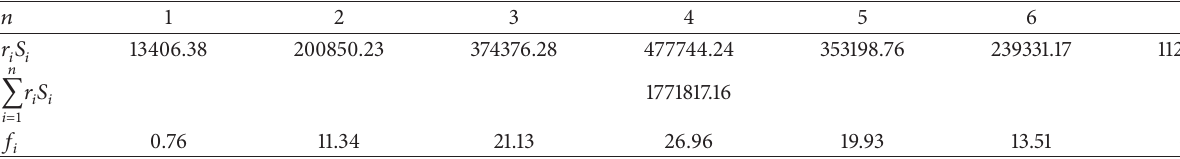
Table 7: Radial structural factors.